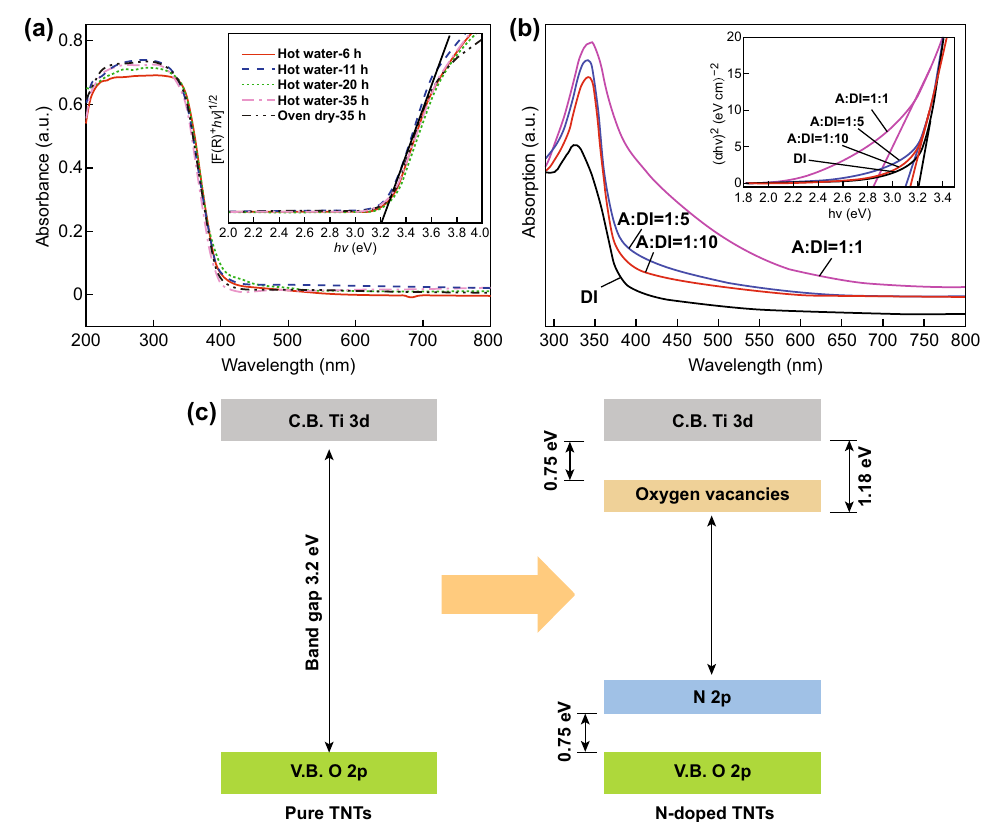
Fig. 12 a UV–Vis absorption spectra of the TiO 2 NT-powders after different heat treatment duration times at 92 (cid:3) C. The inset shows the corresponding estimated bandgap. b The absorption spectra of water immersed TNTs and ammonia solution immersed TNTs with different concentrations. The inset shows the corresponding estimated bandgap, A/DI = Vol ammonia /Vol water . c Schematic of the band structure of pure TNTs and nitrogen-doped TNTs prepared by immersing the as-anodized sample in ammonia solution [39, 55]. Copyright (cid:2) 2011 American Chemical